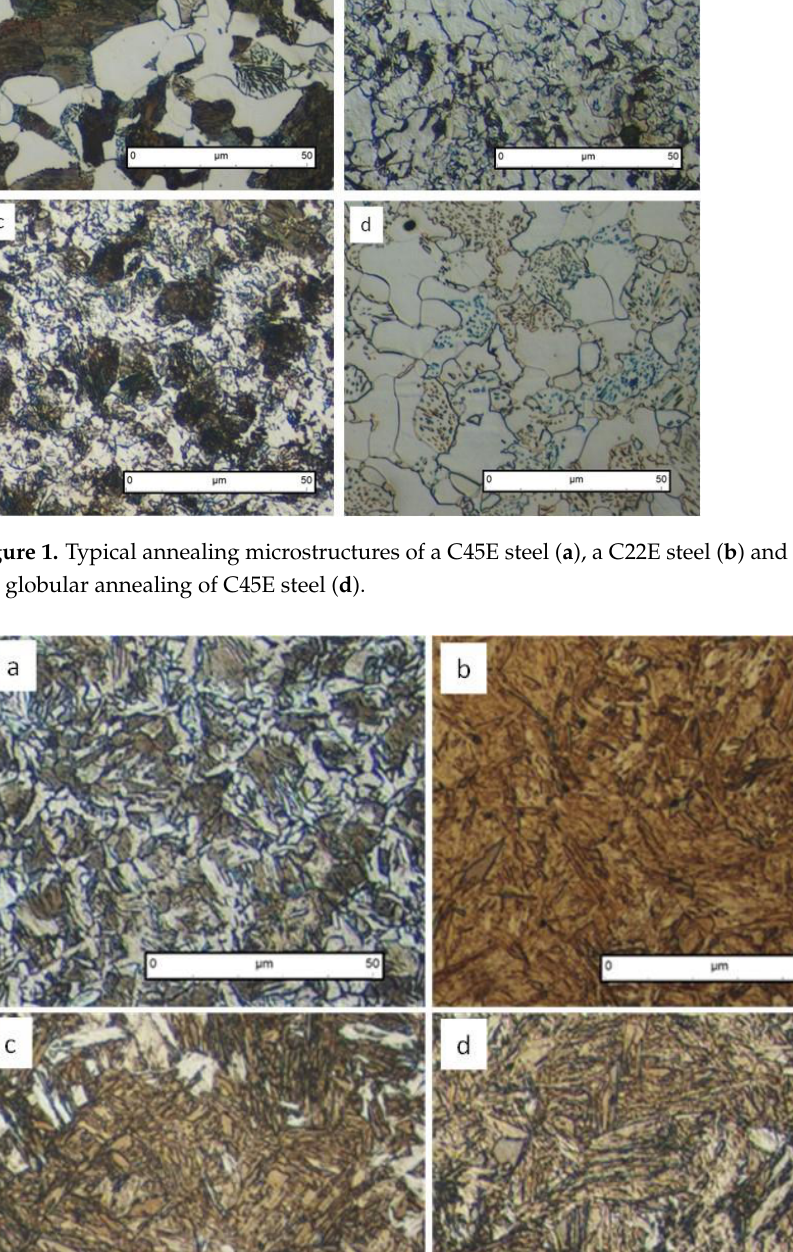
Figure 3. Typical microstructures after quenching + tempering at 450 °C for steels C45E ( a ), 40niCrMo6 ( b ) and 37Cr4 ( c ); ( d ) corresponds to a tempering temperature of 650 °C for a C45E steel.